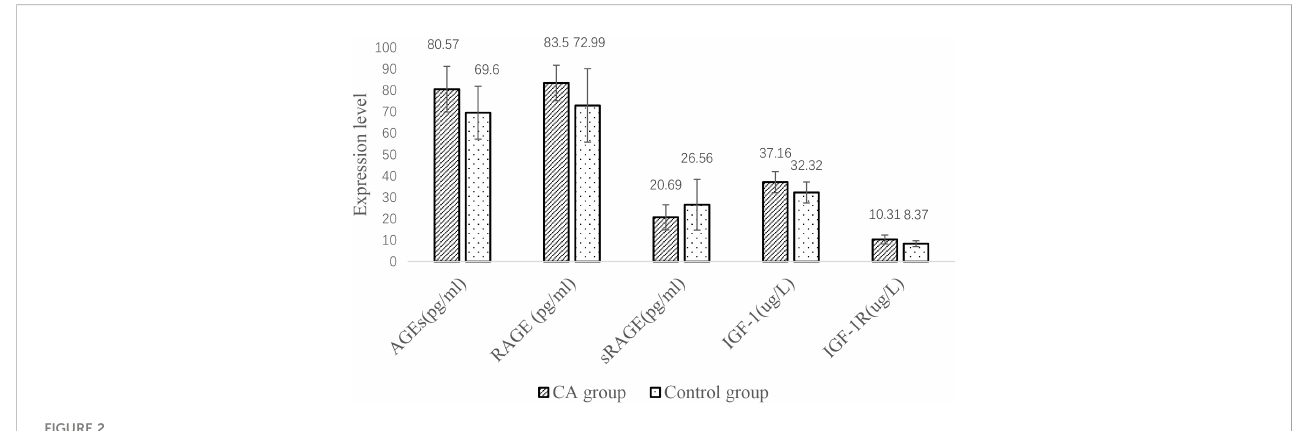
FIGURE 2 Comparison of serum indicators between CA and control groups.